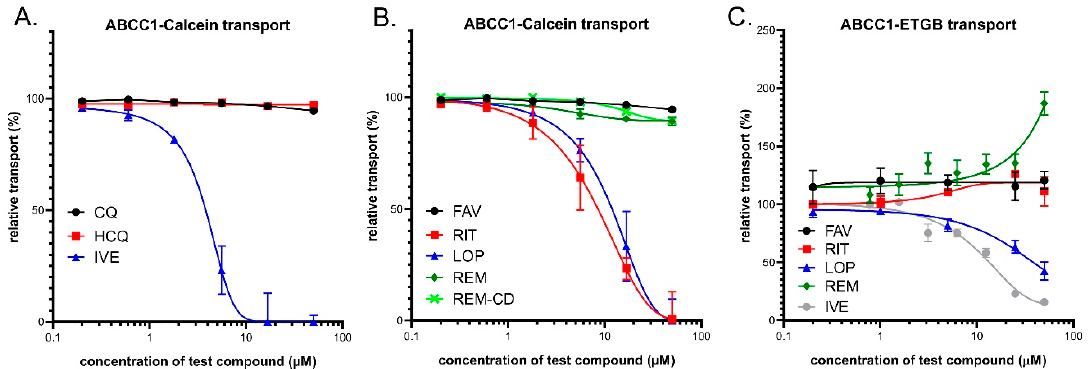
Figure 2. ( A ) and ( B ): Inhibition of ABCC1-mediated CaAM extrusion in intact HL60 cells. Panel C: Inhibition of ABCC1-mediated vesicular uptake of 3 H-estradiol-17b-glucuronide (ETGB). Panel A: Effects of ivermectin (IVE), chloroquine (CQ), and hydroxychloroquine (HCQ). ( B ): Effects of lopinavir (LOP), ritonavir (RIT), favipiravir (FAV), remdesivir (REM), and SEBCD-remdesivir (REM-CD). ( C ): Effects of ivermectin (IVE), lopinavir (LOP), ritonavir (RIT), favipiravir (FAV), and remdesivir (REM).